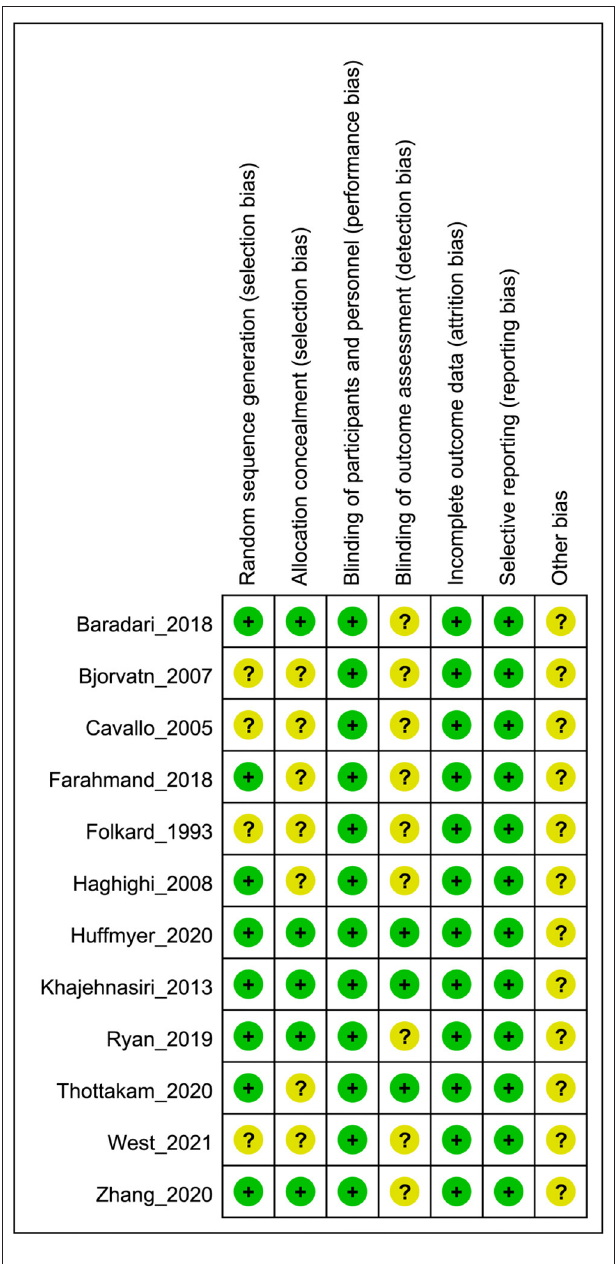
FIGURE 2 | Risk of bias